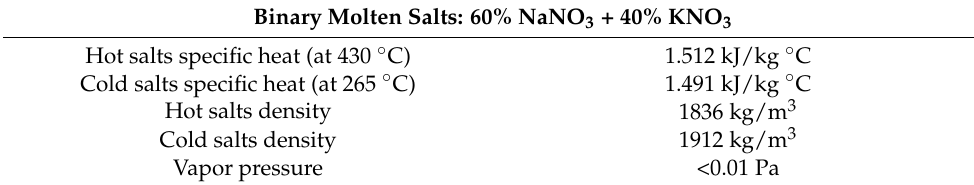
Table 3. Binary molten salts properties